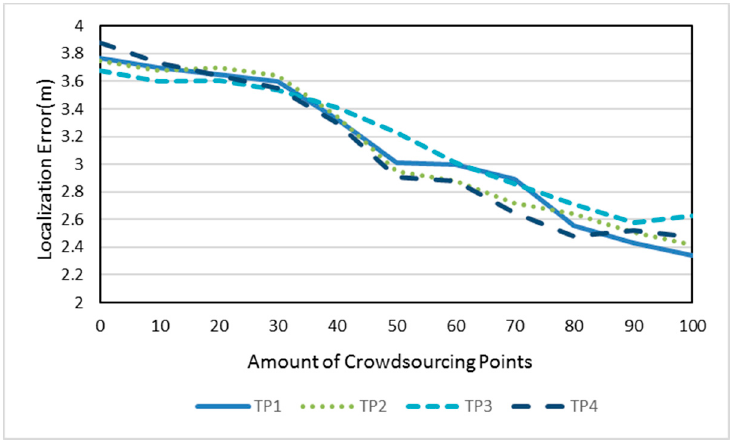
Figure 12. Localization error of TP1, TP2, TP3, and TP4 with different amounts of crowdsourcing- based points.